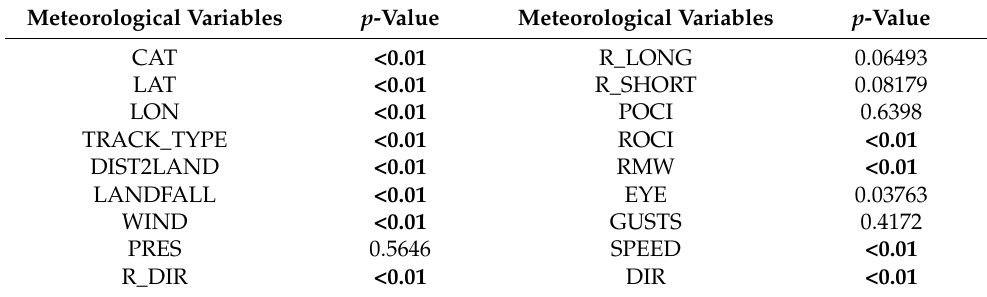
Table 3. The results of smoothness tests of typhoon meteorological